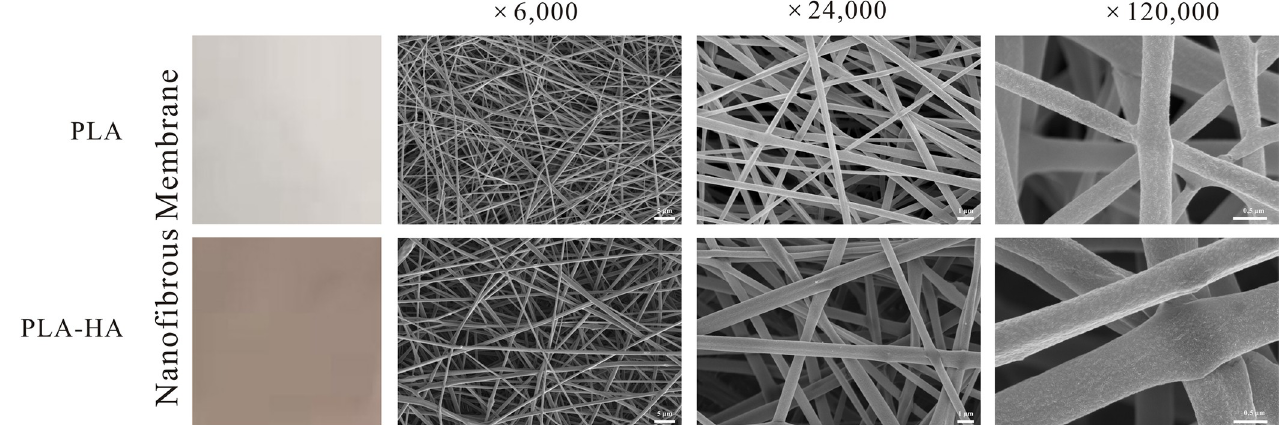
Fig 2. Visual appearance and surface morphologies of PLA and PLA-HA nanofibrous membranes. Scale = 5 μ m, 2 μ m and 0.5 μ m from low magnification to high magnification in SEM images.